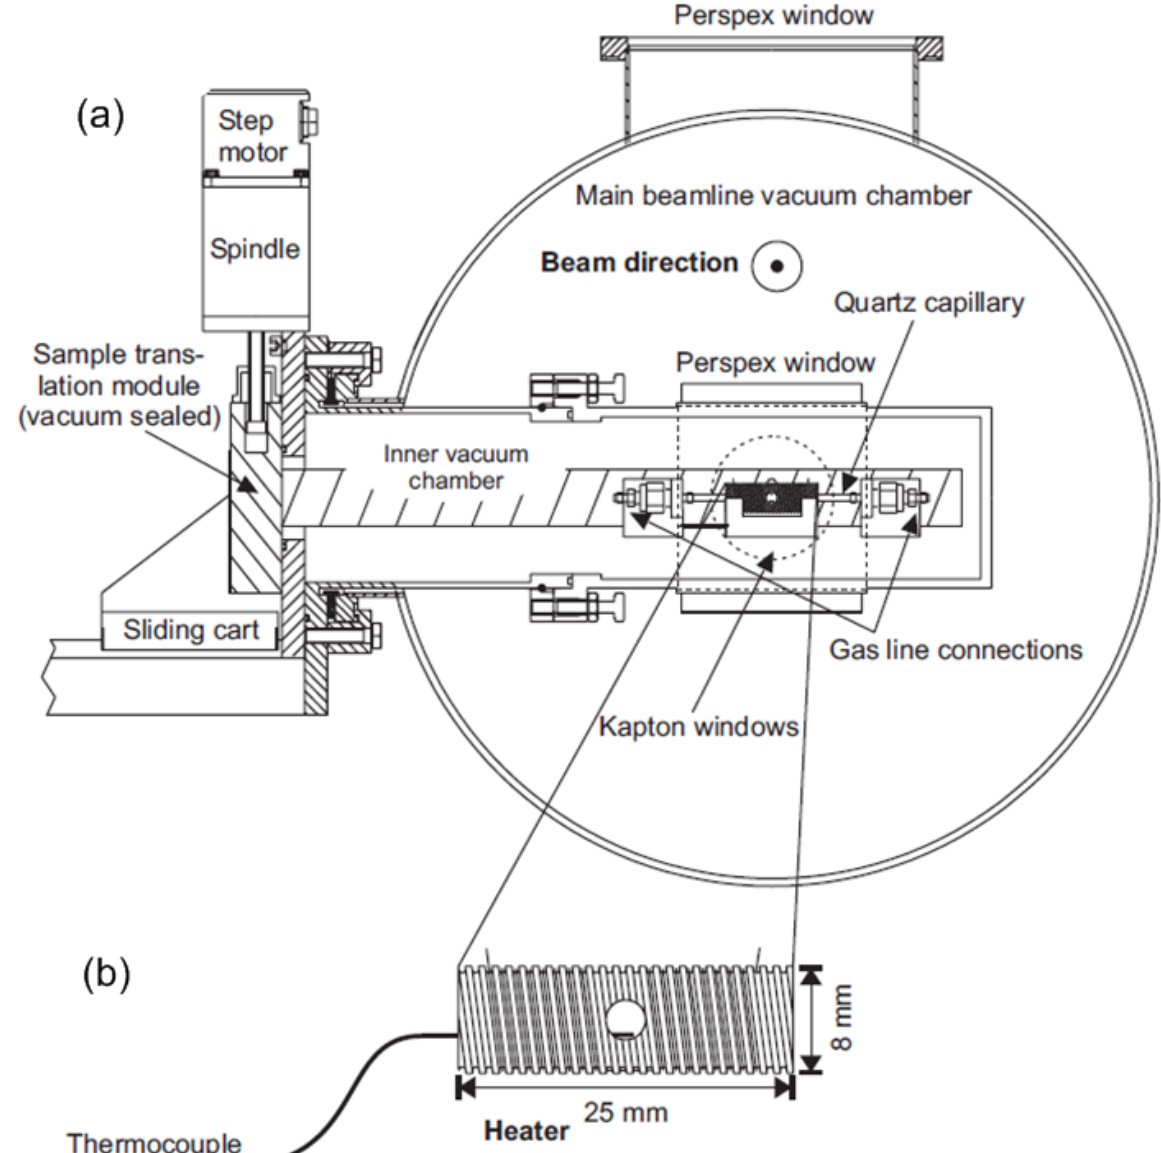
Figure 3: (a) View down the JUSIFA vacuum chamber/flight tube along the synchrotron beam direction, showing the inner vacuum cham- ber with the capillary micro reactor in measuring position. The entry points for gas and electrical current leads, thermocouple and vac- uum pump connection are on the sample translation module in the left-hand part of the drawing. (b) Enlarged view of the heater element showing heater wire and central opening allowing beam passage. Also, the positioning of the thermocouple is shown (Reproduced with permission of the International Union of Crystallography)